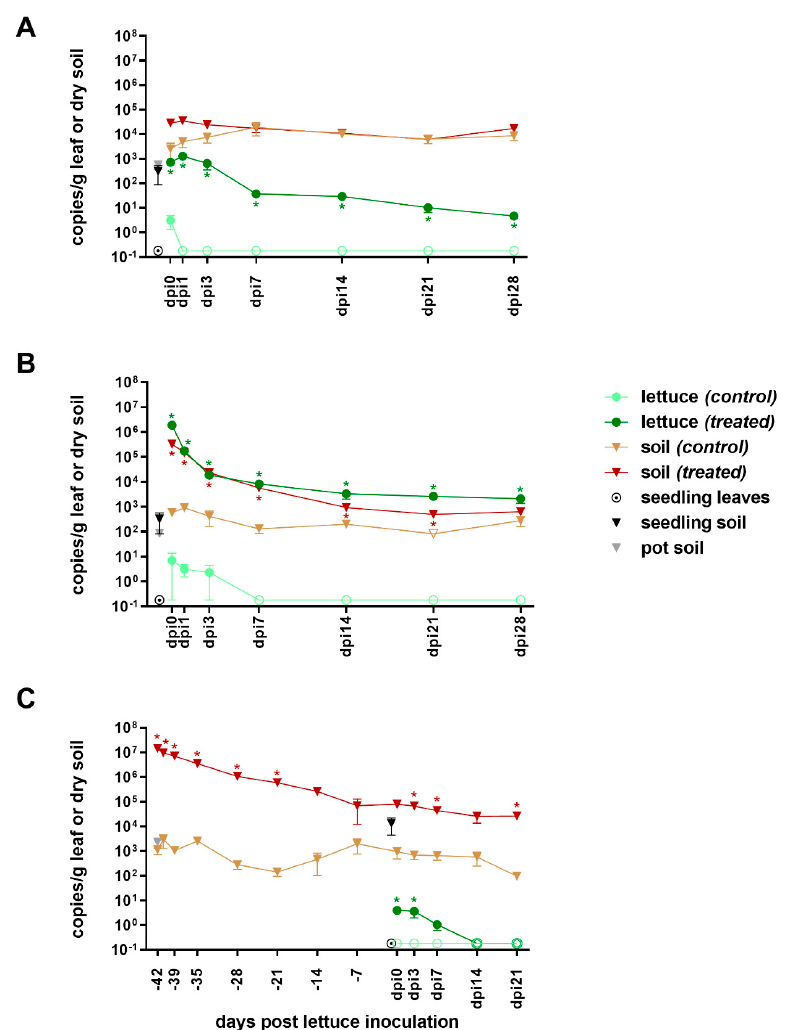
Figure 2. Detection of bla CTX ‐ M ‐ 15 in soil ( ‐ ▼ ‐ ) and lettuce ( ‐●‐ ) from introduction of extended ‐ spectrum β -lactamase (ESBL)-producing E. coli pEK499 until harvest. Low- and high-level contamination via water ( A and B , respectively) and via manure ( C ) are shown. Empty symbols indicate values below the respective limit of detection. Error bars indicate standard error of the mean (SEM, n = 3). Significant differences between treatment and control ( p < 0.05) are marked with an asterisk.